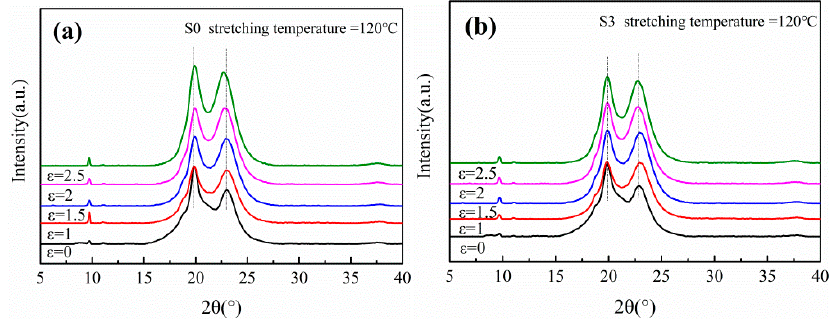
Figure 5. The WAXD curves of uniaxially stretched ( a ) PA612 and ( b ) PA612 / SiO 2 films at di ff erent strain.